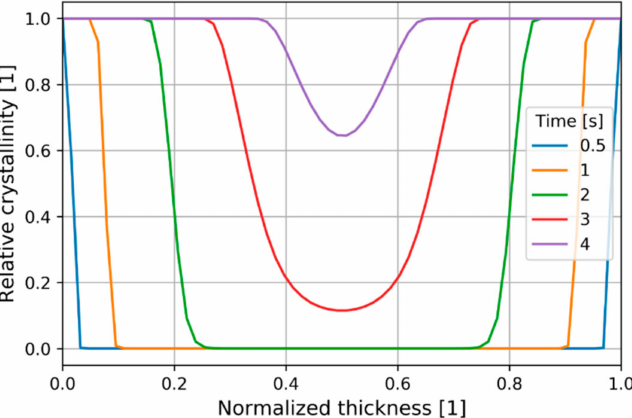
Figure 11. Relative crystallinity distribution at P2.